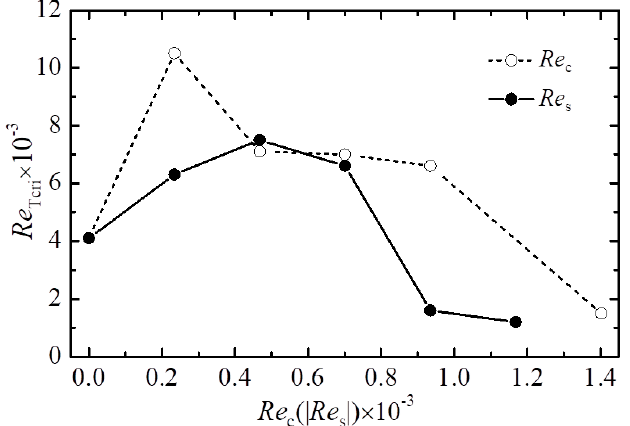
Figure 3. Variations of critical thermal capillary Reynolds numbers with the crystal or crucible rotation Reynolds number.